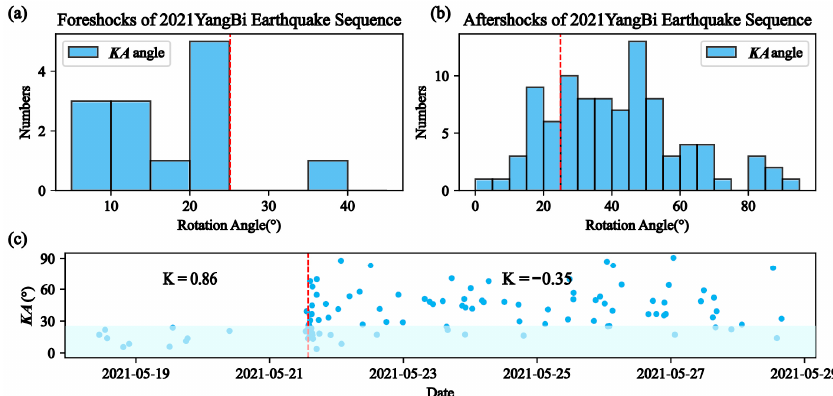
Figure 7. Temporal variation in KA angle and K value in the Yangbi earthquake sequence. ( a ) KA angle of the foreshock sequence. ( b ) KA angle of the aftershock sequence. ( c ) K value for the consistency of the foreshock and aftershock (light green indicates KA ≤ 25°), and the red dotted line separates the foreshock and aftershock. The red dotted lines in ( a , b ) indicate 25° KA angle.